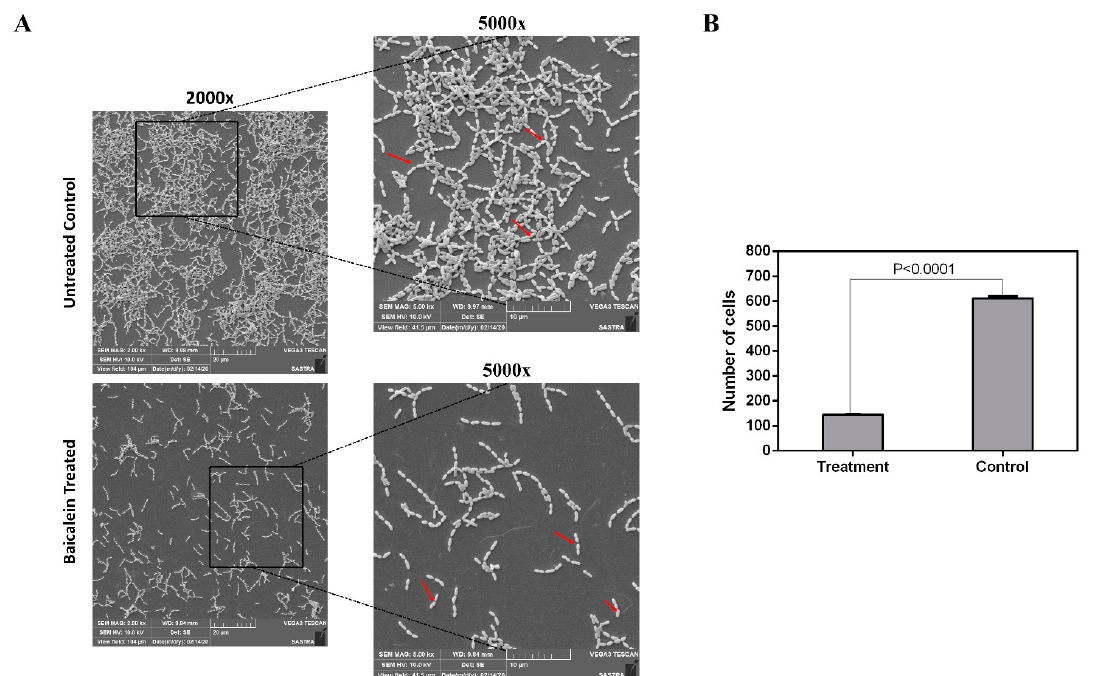
Figure 5. ( A ) SEM (Scanning Electron Microscopy) micrograph depicting the effect of baicalein on biofilm formation. Arrows indicate the long and short chains of S. mutans in control and treatment, respectively. ( B ) Reduction in number of cells in the baicalein treated when compared to untreated control biofilms where the treated cells displayed an adhered cell count of <100 cells when compared to the untreated control which had around >500 adhered cells.